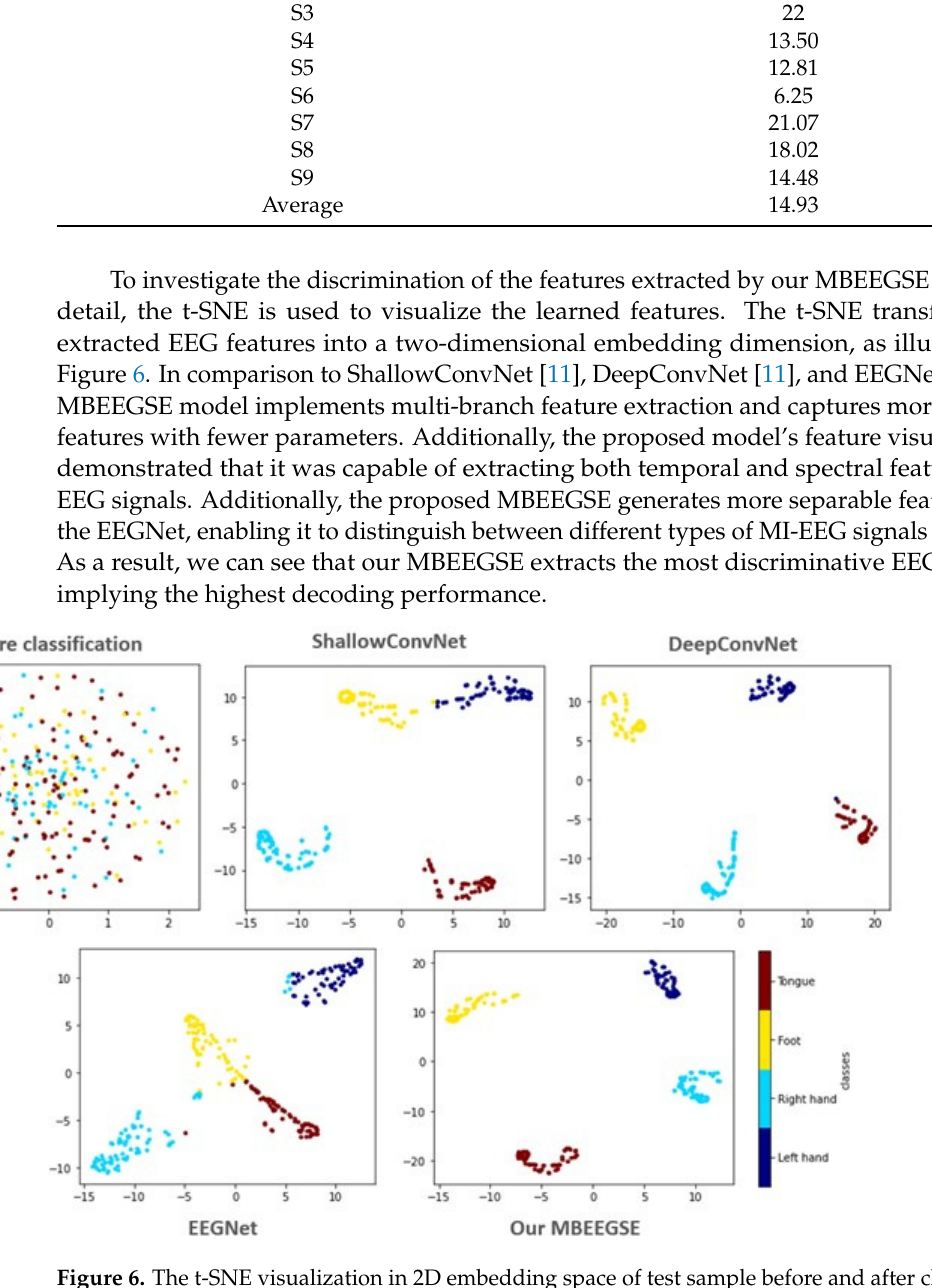
Figure 6. The t-SNE visualization in 2D embedding space of test sample before and after classified by different methods from the third subject in the BCI-IV2a.